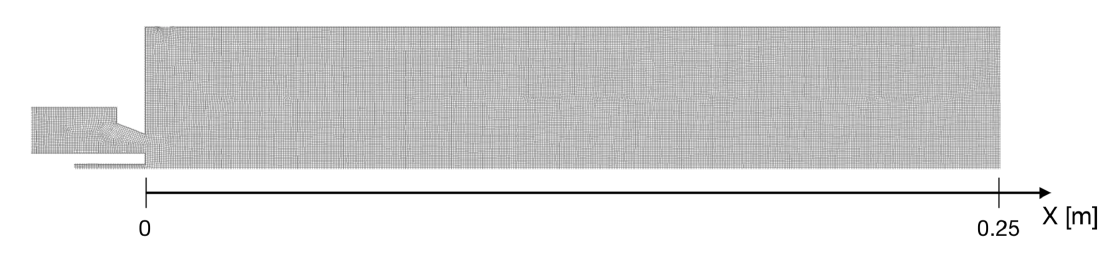
Figure 14. Computational grid for the 2D axisymmetric domain of the combustion